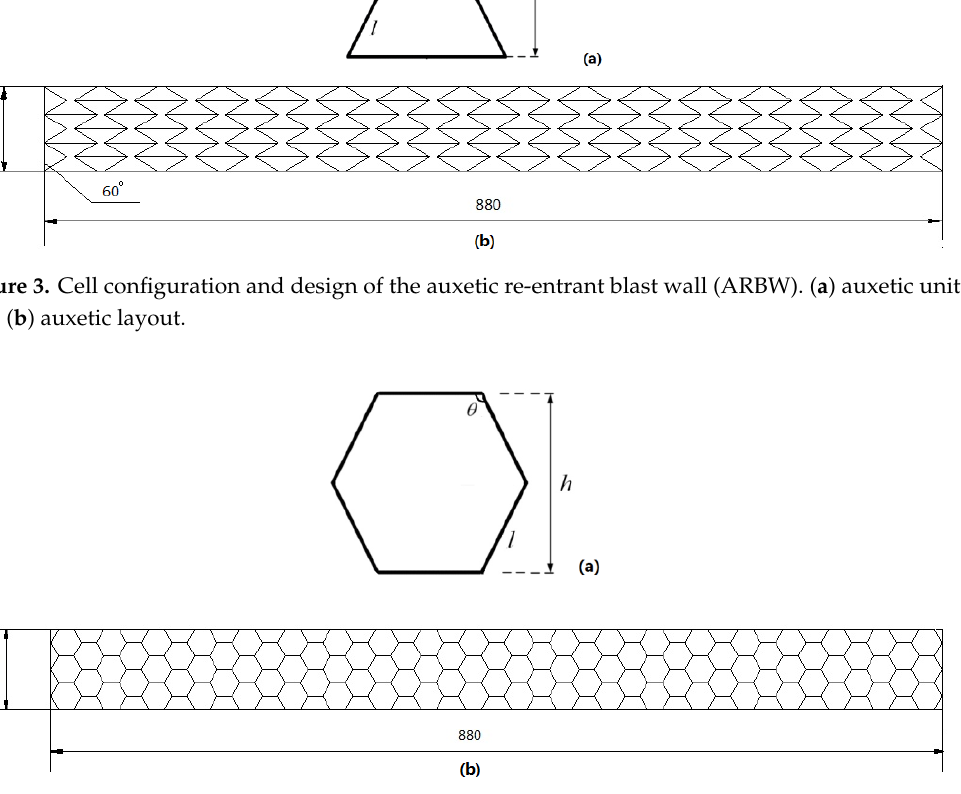
Figure 3. Cell configuration and design of the auxetic re-entrant blast wall (ARBW). ( a ) auxetic unit cell, ( b ) auxetic layout.